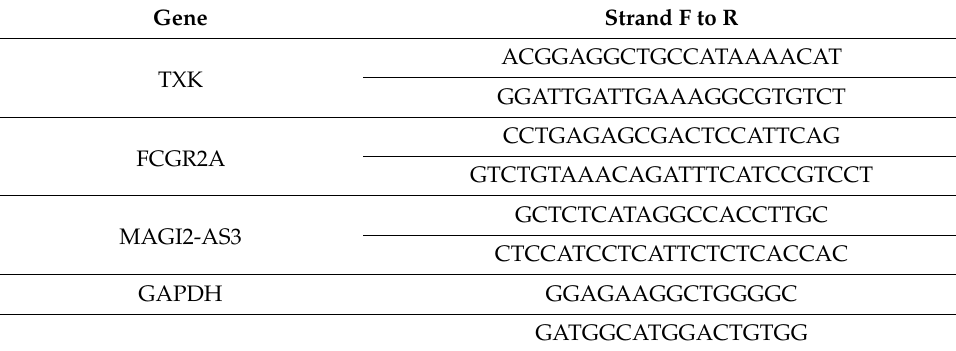
Table 1. Primer sequences used for RNA seq validation.